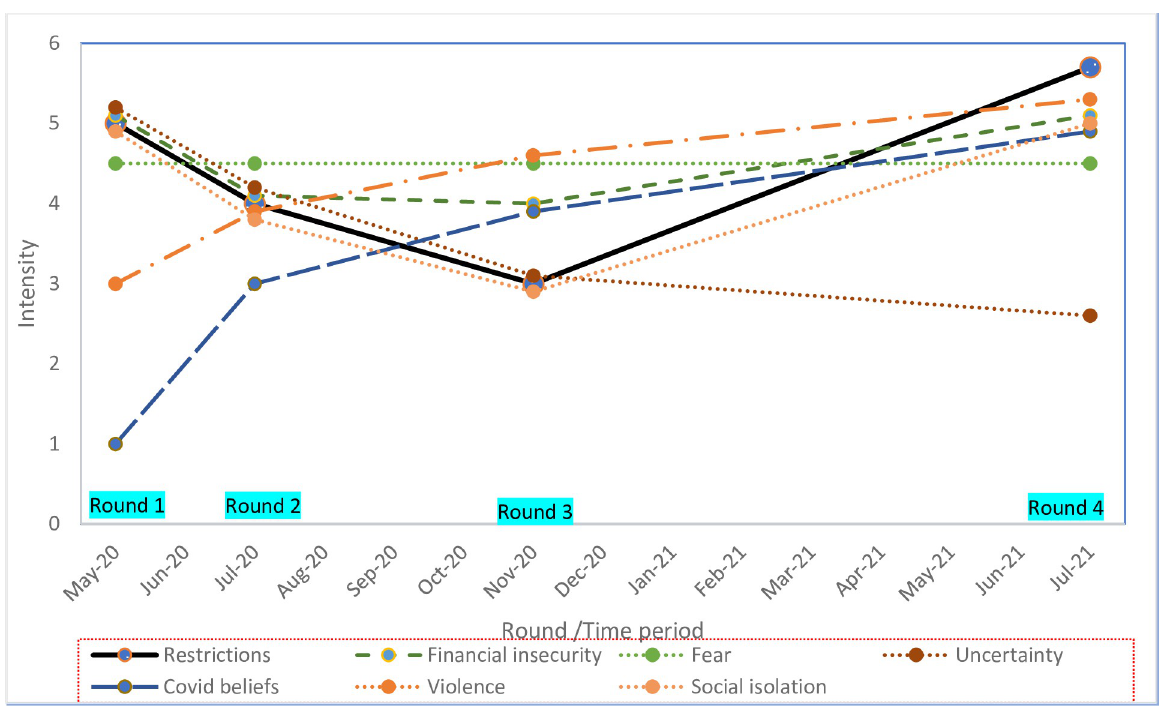
Fig 3. Intensity of themes over time and data collection rounds 1, 2, 3, 4 (intensity defined as a combination of frequency mentioned and words used to describe strength of feelings).